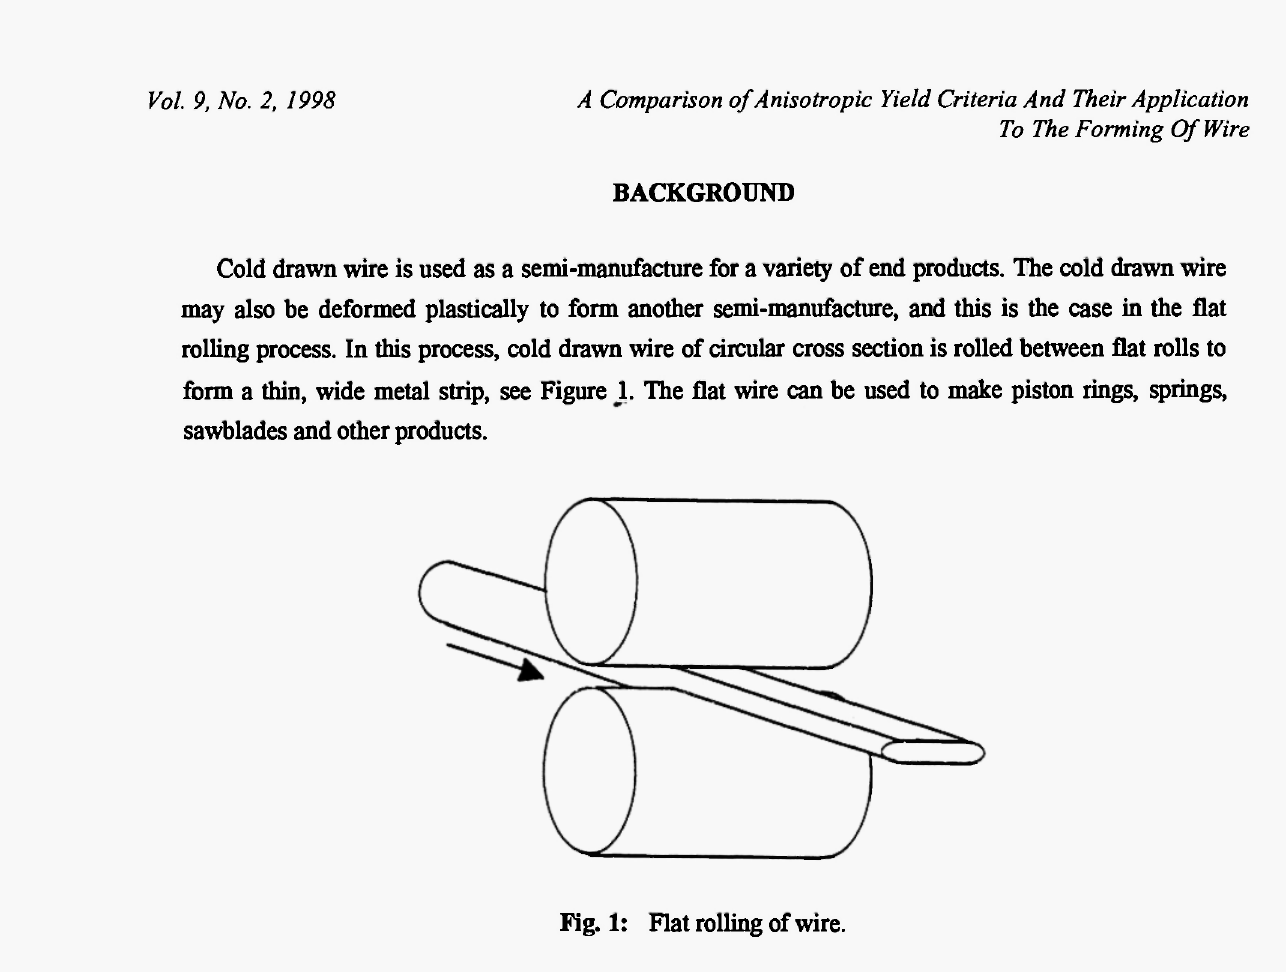
Fig. 1: Flat rolling of